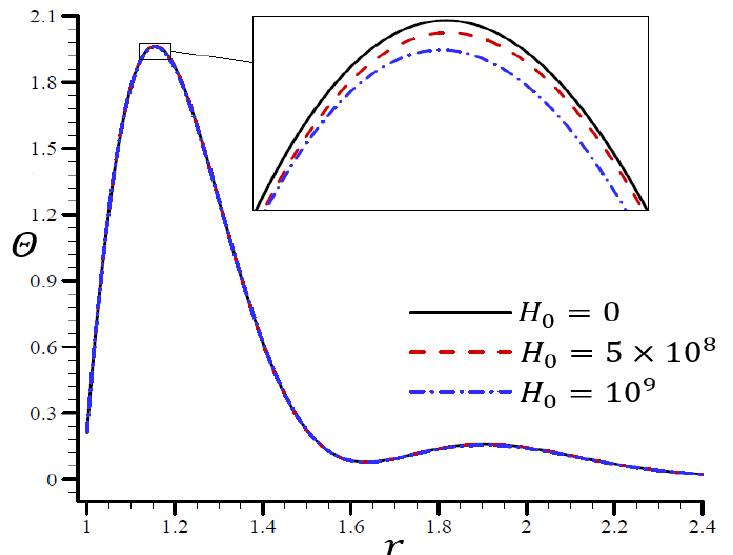
Figure 12. The influence of H 0 on temperature Θ through the radial direction of a spherical hole using the RTPL model.